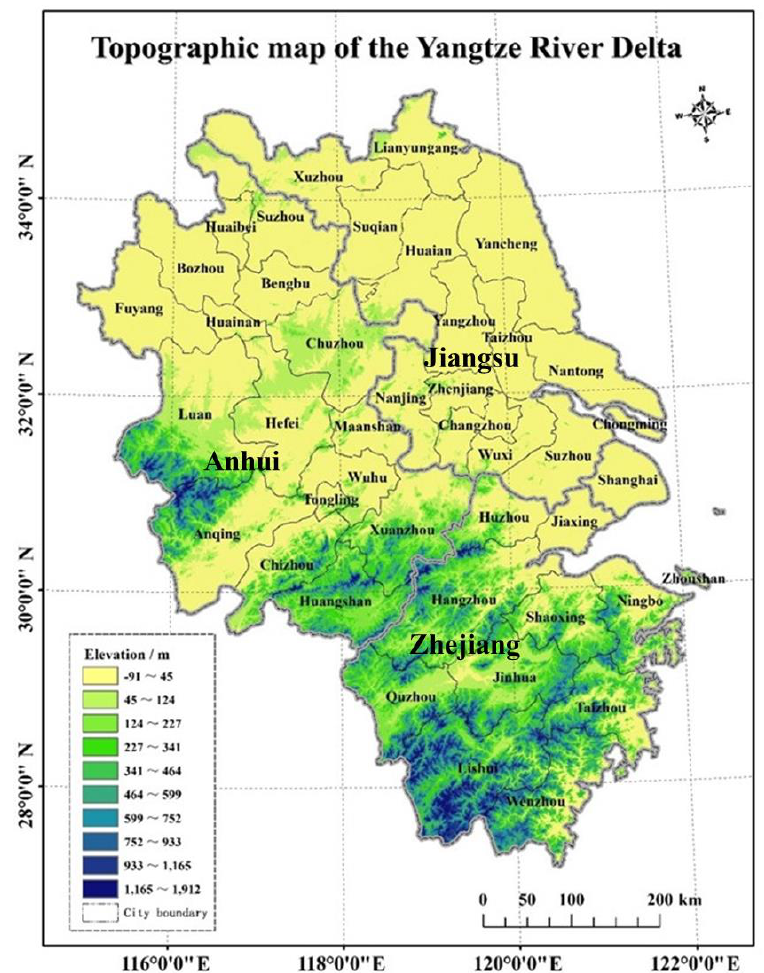
Figure 1. Topographic map of the YRD region.